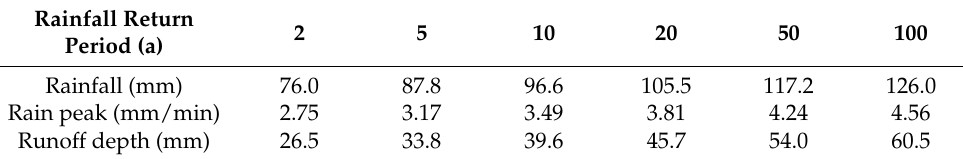
year return period; ( f ) 100-year return period. Table 4. Runoff statistics of falling water under different